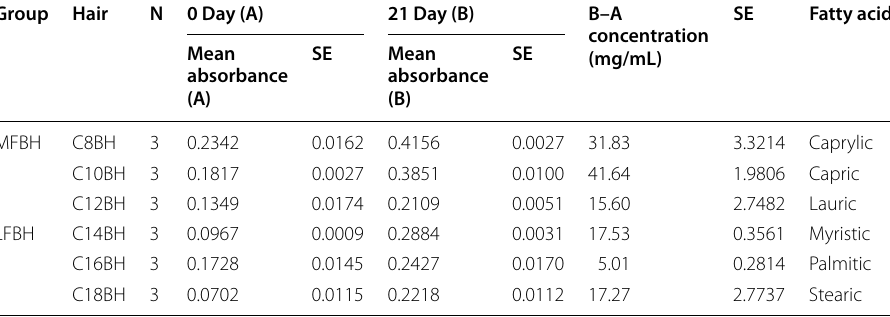
Table 3 Concentration of fatty acids in BH after 21 days of fatty acid hair treatment Group